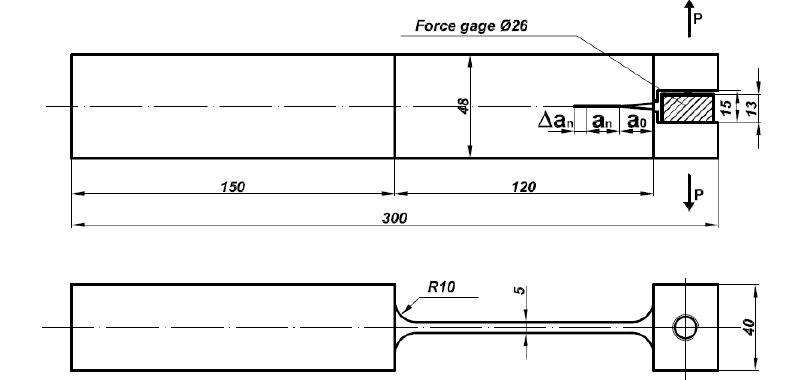
Figure 3: Drawing Specimen #3V and a scheme of its loading.